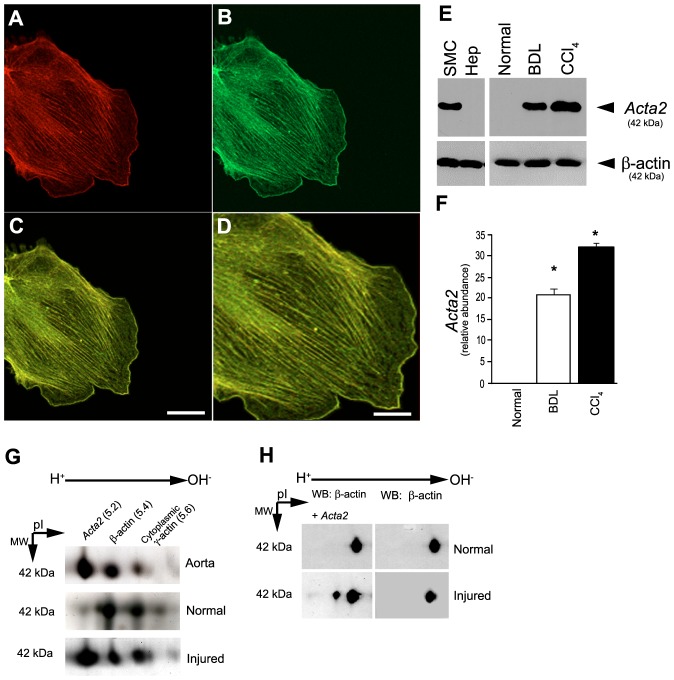
Actin isoform expression after liver injury.In (A–C), stellate cells were isolated after carbon tetrachloride (CCl4) induced liver injury as in Methods and plated on glass coverslips. Twenty-four hours later, smooth muscle α actin (Acta2) (A, Texas red) and nonmuscle β-actin (B, FITC) were detected by immunocytochemistry as in Methods. In (C and D) are shown overlays, revealing co-localization of actins (C: bar = 10 microns; D: bar = 5 microns). Identical results were obtained with cells after either form of liver injury, and images are representative of over 20 others. In (E), stellate cells were isolated from normal livers or 8 days after bile duct ligation or 10 doses of carbon tetrachloride and immediately subjected to immunoblotting as in Methods. Representative immunoblots shown depict duplicate, identical, samples probed for each Acta2 and anti-cytoplasmic β actin (7.5 µg total protein). In (F), specific bands were scanned, quantitated and expressed graphically (n = 4 for each model of injury, *p<0.001 compared to normal). In (G), stellate cells from normal or injured livers were immediately lysed and equal amounts (40 µg) of cellular proteins were subjected to 2-D gel electrophoresis as in Methods. Notably, we also made a theoretical estimation of isoactin PIs by in silico analysis of each actin isoform ([67](Figure S1)). Representative examples (of greater than 20 separate experiments) reveal specific actin isoforms, and after injury (bile duct ligation), new expression of an α isoform (two-D gels are shown in the standard international format with pI ranging from acidic to basic, left to right). In (H), a representative immunoblot of similarly prepared protein samples after 2-D gel electrophoresis is shown (200 µg total protein each). As described in Methods, nitrocellulose membranes were probed sequentially with anti-cytoplasmic β-actin then anti-Acta2 (using the same ECL detection method each time, thus accounting for repeat detection of the β-actin band). Abbreviations: Acta2 - smooth muscle α actin; BDL - bile duct ligation; CCl4 - carbon tetrachloride.